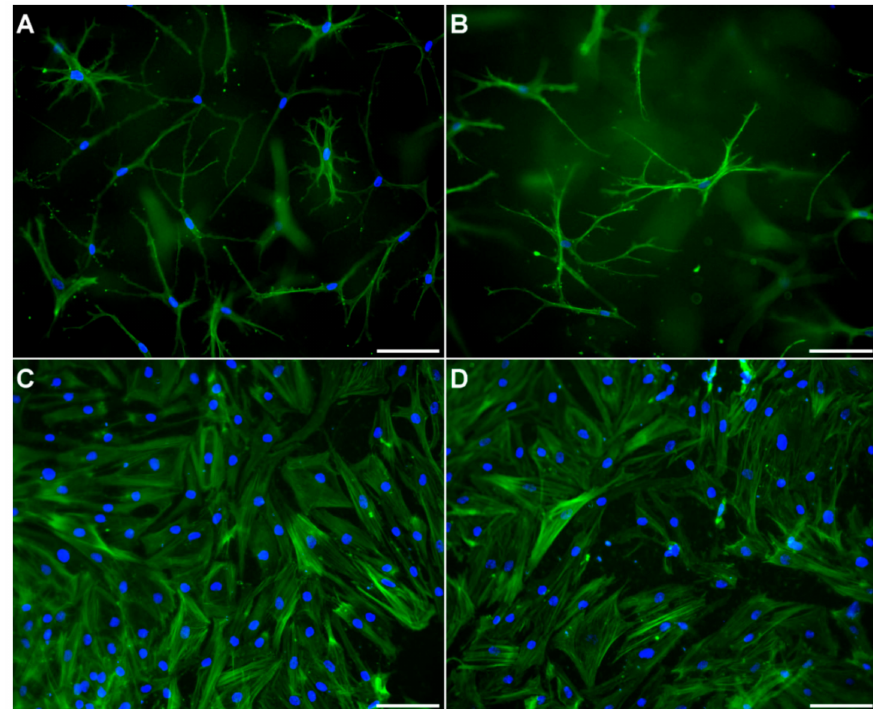
Figure 3. Osteocytes ( A , B ) and osteoblasts ( C , D ) in single ( A , C ) and co-culture ( B , D ). Osteocytes were obtained by in vitro di ff erentiation from mature osteoblasts in collagen gels in a transwell insert. Osteoblasts were di ff erentiated from pre-osteoblasts and added on the outer surface of the insert membrane. Fluorescence images of osteocytes after staining the cytoskeleton (Alexa 488, green) and nuclei (DAPI, blue). Scale bar represents 100 µ